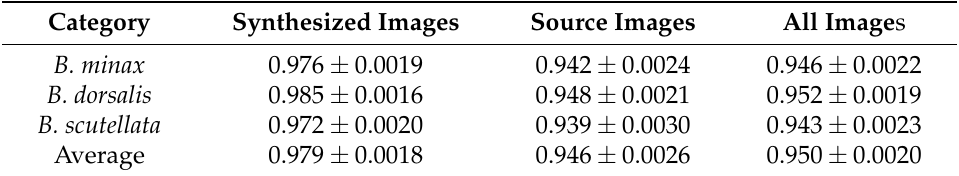
Table 5. Statistical analysis of the recognition accuracies for three species of target citrus fly pests on the synthesized yellow paper images and source (non-synthesized)